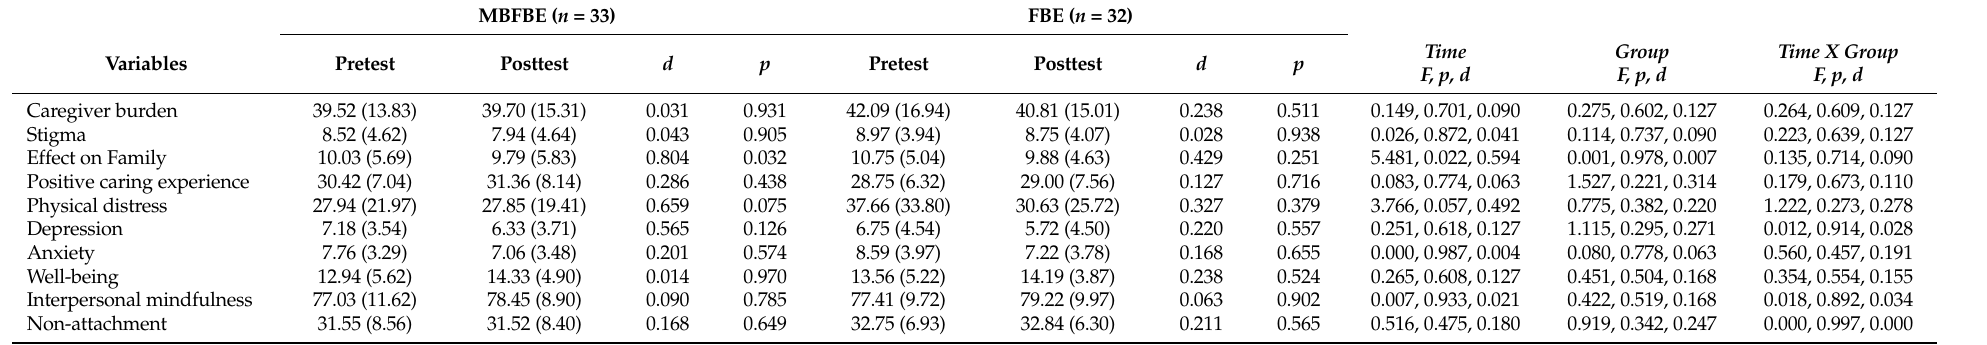
Table 3. Measures over time for the MBFPE group and FPE group on outcomes of caregivers (caregiver burden as covariates). MBFBE ( n = 33)